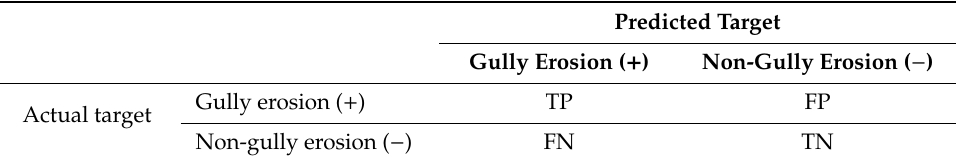
Table 1. Confusion matrix of machine learning models in this